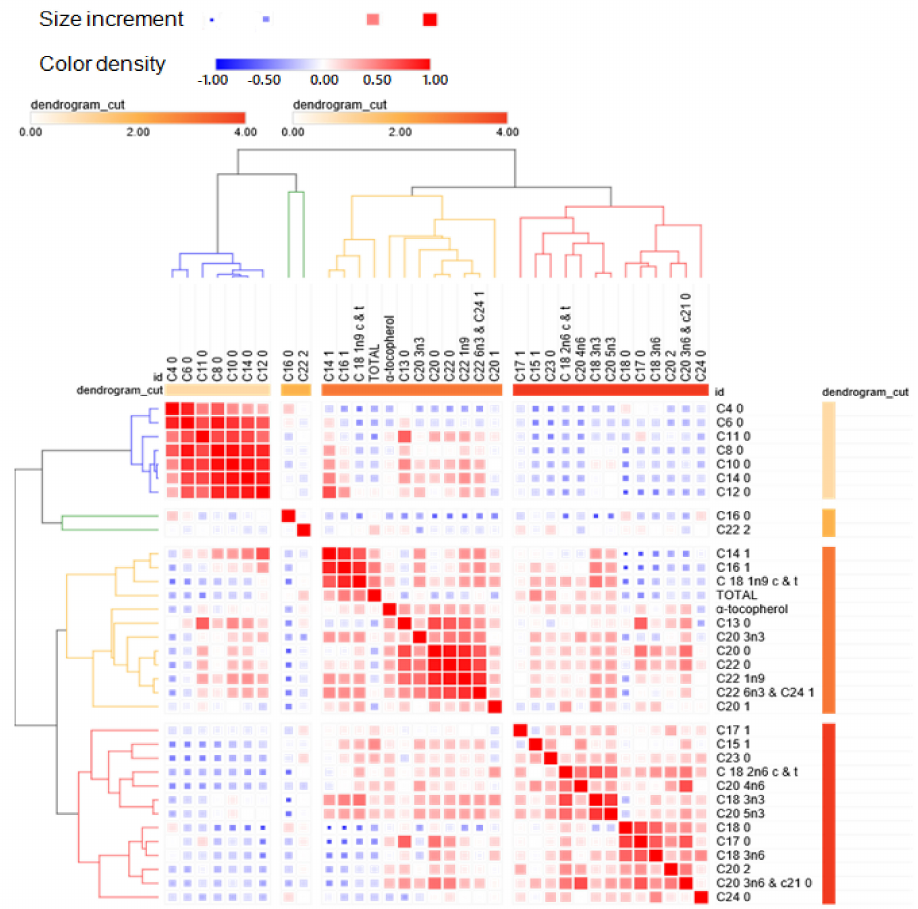
Figure 2. Hierarchical cluster correlation matrix of α -tocopherol ( α -TOC) and fatty acids (FAs) in organic milk (OM). Each square indicates the Pearson’s correlation coe ffi cient of a pair of compounds, and the correlation coe ffi cient values are represented by the intensity of blue or red color combined with the square size, as indicated on the color and size